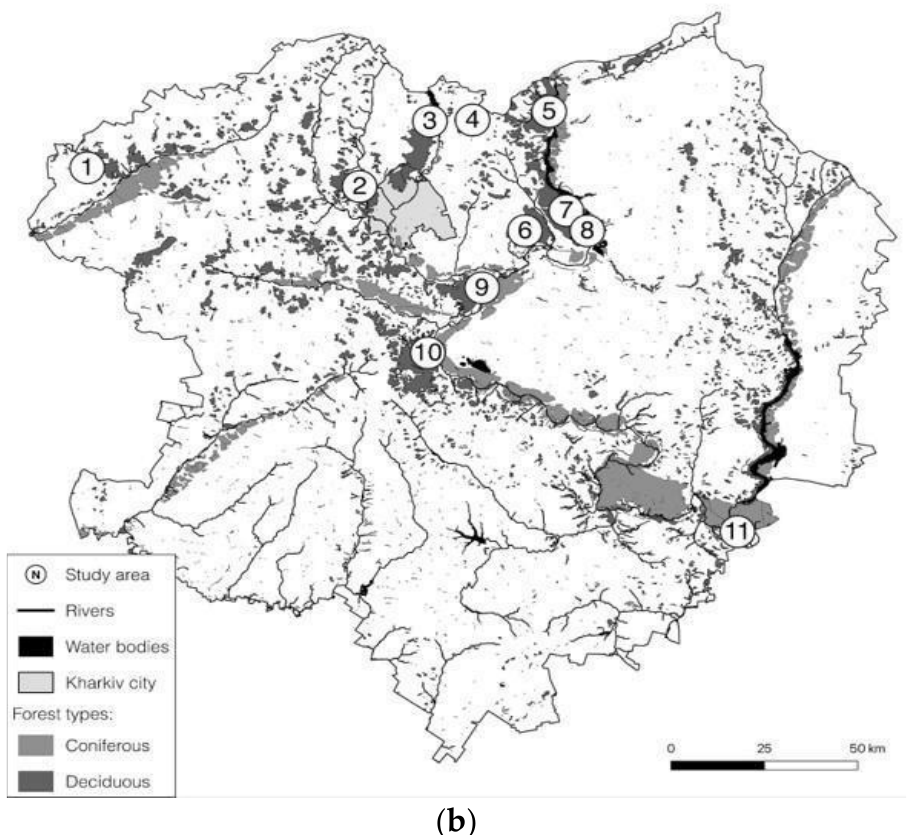
Figure 1. ( a ) Ecoregions of Ukraine and the location of the Kharkiv region (indicated by crossed-lines mesh). CEMF — Central European mixed forests; CMF — Carpathian montane forests; CSFC — Crimean submediterranean forest complex; EEFS — East European forest steppe; PMF — Pannonian mixed forests; PS — Pontic steppe; white lines — main rivers in Ukraine. ( b ) Locations of study plots in the Kharkiv region (Oblast); 1 – 11 — study plots; 1 — Koziyivka (KOZ); 2 — Karavan (KAR); 3 — Liptsy (LIP); 4 — Neskuchne (NES); 5 — Starytsia (STR); 6 — Tetleha (TET); 7 — Pechenihy (PEC); 8 — Pechenihy2 (PEC2); 9 — Mokhnach (MOK); 10 —Homil’sha (HOM ); 11 — Yaremivka (YAR).